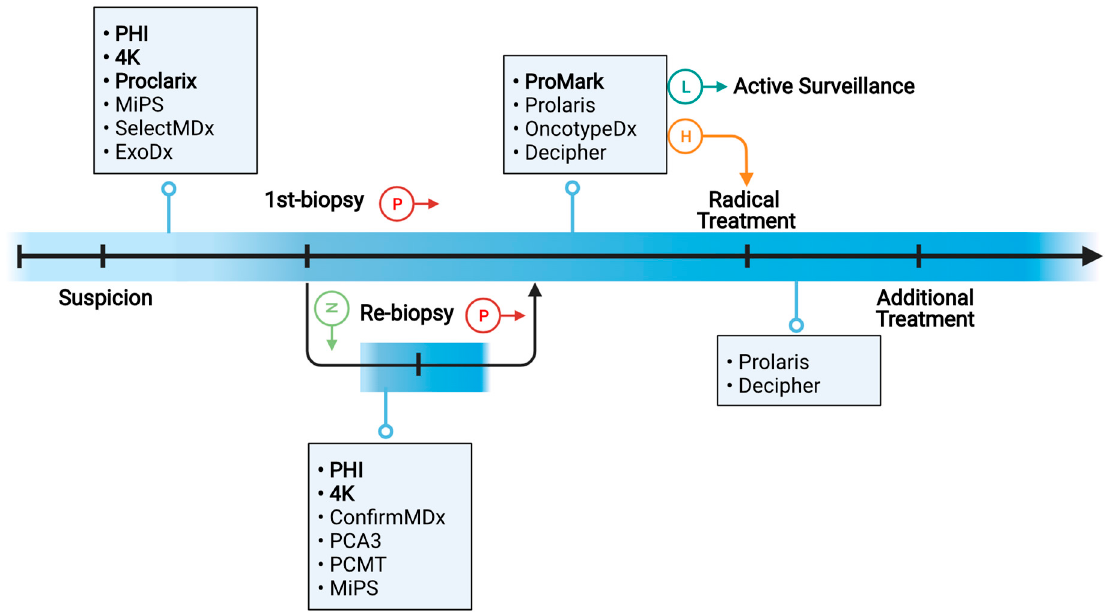
Figure 1. Schematic overview of the clinical needs for molecular biomarkers in various settings. Boxes present commercially available PC biomarkers, among which protein biomarkers are in bold font.